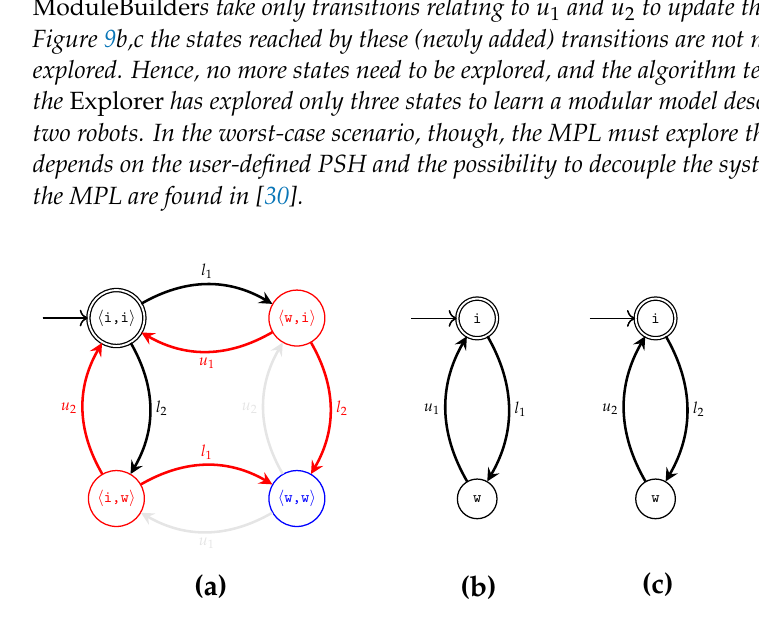
Figure 9. MPL– Final Iteration Figure 9. MPL—Final Iteration. ( a ) Explorer; ( b ) R1; ( c ) R2.